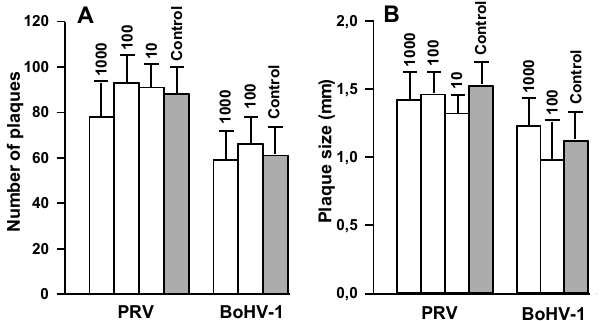
Figure 5B. The 2,5-DHBA–gelatin conjugate had no inhibitory effect on PRV and BoHV-1 cell-to-cell spread.